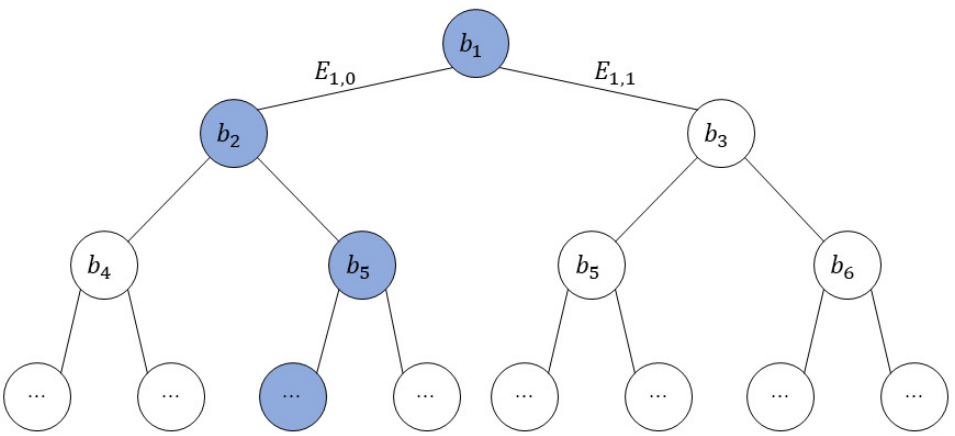
Figure 3. Decision path of the classification